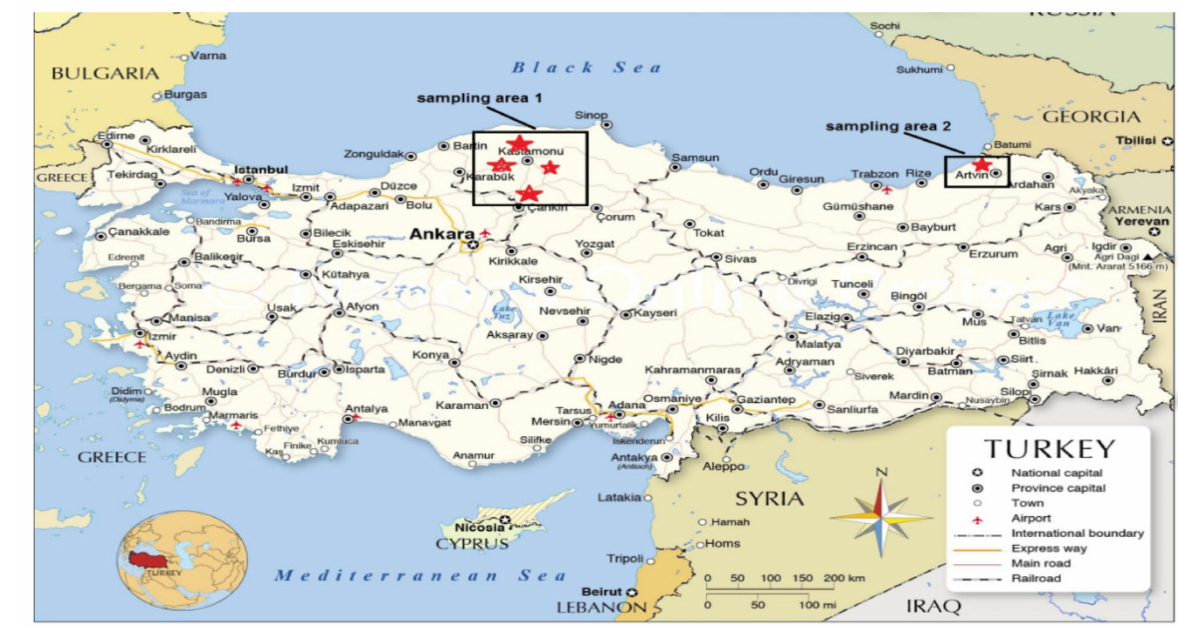
Figure 1. Map of the study area with the points of data